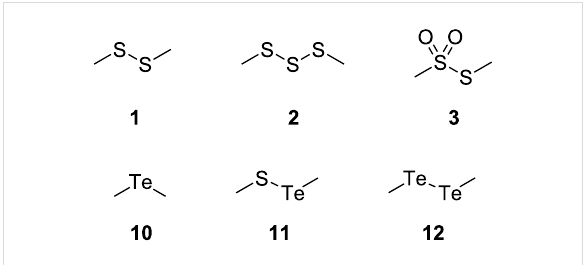
Figure 2: Volatiles from P. gallaeciensis DSM 17395 and R. pomeroyi DSS-3. Feeding of [ 2 H 6 ]DMSP results in deuterium incorporation into compounds 1 – 3 , feeding of DMTeP results in the formation of com- pounds 10 – 12